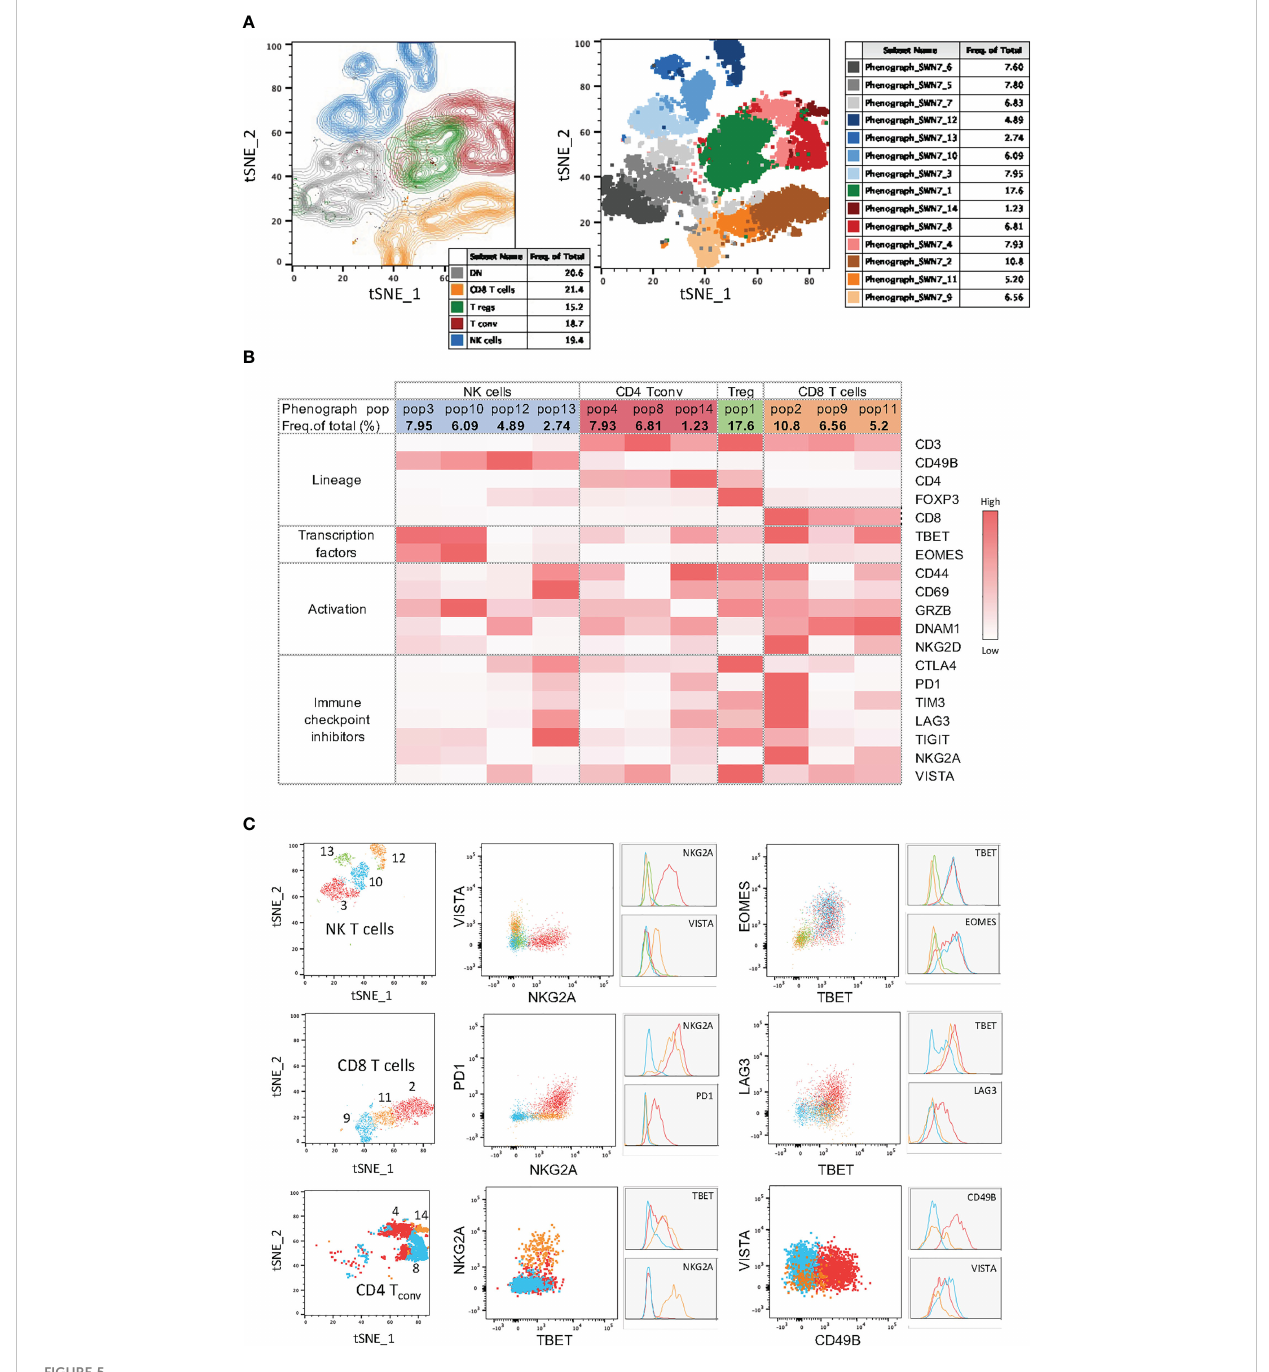
FIGURE 5 High-dimensional data analysis on tumor in fi ltrating immune cells from YUMM UV 1.7 tumors stained with Panel 1. (A) Left: tSNE plots on concatenated T and NK cells from 4 YUMM UV 1.7 tumors with overlayed colored manual gates for CD8 + (orange), CD4 + T conv (red), T regs (green), NK (blue), and double negative (CD4 - CD8 - ) T cells (grey). Contour plots reveal cell density and main subpopulations. Right: Same tSNE as on the left where cells are color-coded according to the 14 clusters identi fi ed with PhenoGraph. (B) Mean fl uorescence intensity (MFI) heatmap for the indicated markers across the 4 main immune cell population and within each cluster obtained with PhenoGraph. Marker expression intensity is indicated by the scale bar at the right of the table where white is low and red is high. (C) Left column: tSNE plots showing cluster overlays in 3 main immune cell population: NK cells, CD8 + T cells, and CD4 + T conv . Middle and right colums: same cluster overlays analysed for differentiation and exhaustion markers. Both dot plots and corresponding histograms are